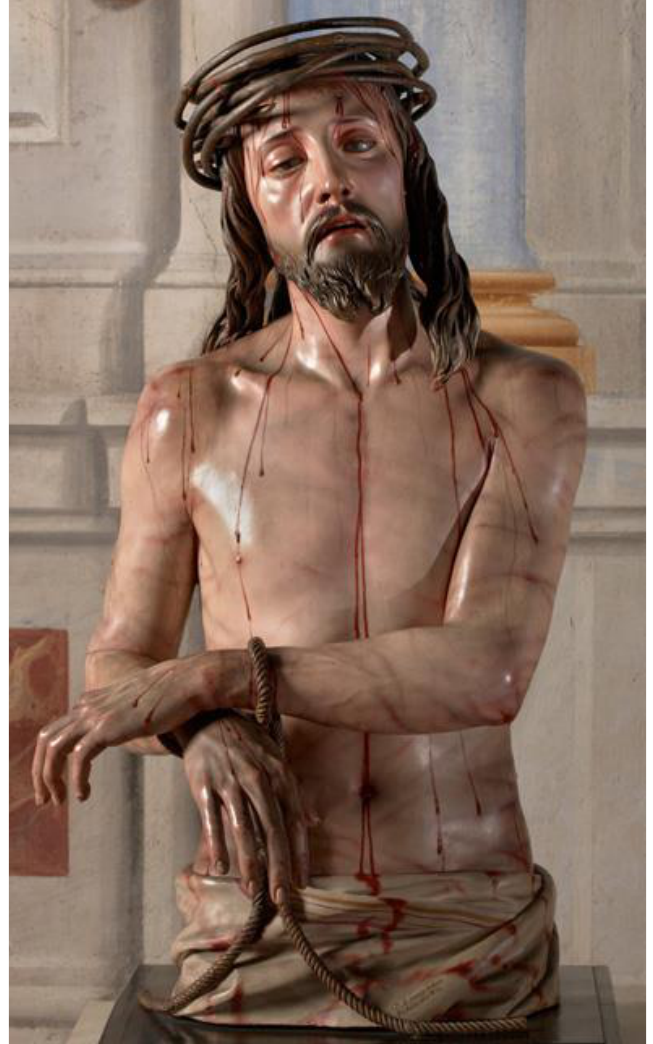
Figure 4. Christ as the Man of Sorrows, by Pedro de Mena, 1673. Convento de las Descalzas Reales, Madrid © 2009 Photo Gonzalo de la Serna. Patrimonio Nacional, Madrid.